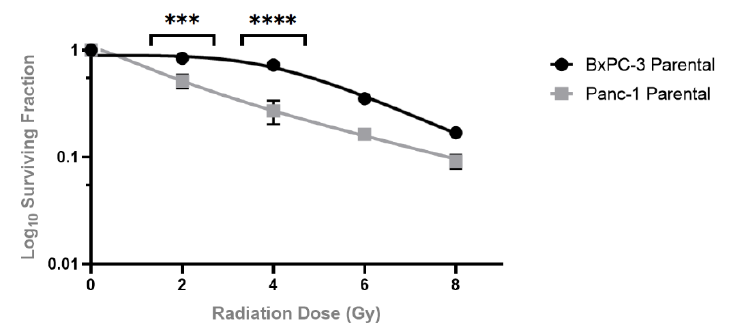
Figure 2. Clonogenic survival of PDAC cell lines when treated with radiotherapy. BxPC-3 and Panc-1 parental cell lines were irradiated with 2 Gy, 4 Gy, 6 Gy, and 8 Gy. Control cells were mock-irradiated (0 Gy). Data are represented as the mean ± SEM ( n = 3). Two-way ANOVA with Tukey’s post-hoc test was performed for statistical analysis, comparing BxPC-3 cells to Panc-1 cells at 2 Gy (*** p = 0.0010), 4 Gy (**** p < 0.0001), 6 Gy p = 0.1213) and 8 Gy ( p = 0.9495).